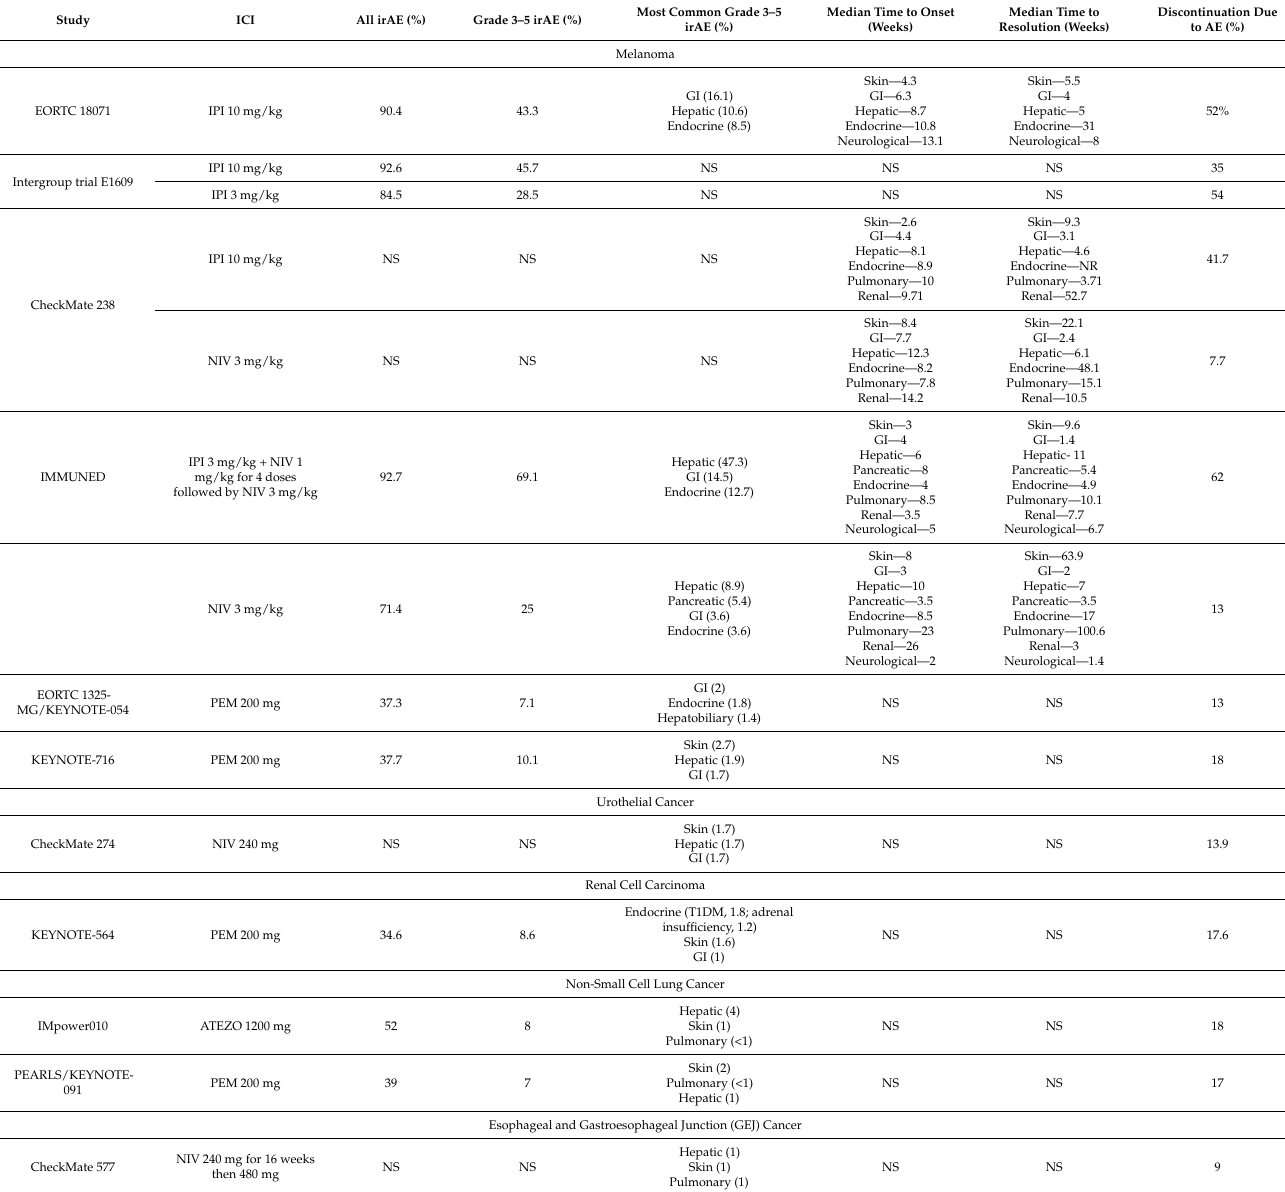
Table 3. Summary of immune-related adverse events of ICIs used in the adjuvant